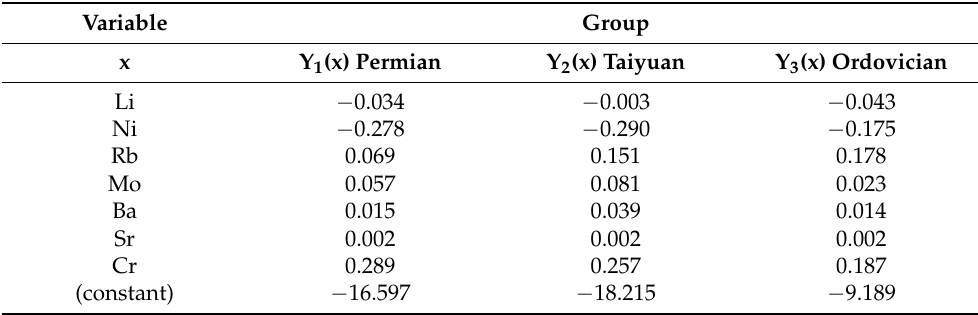
Table 8. Estimation of coefficients (C 0g , C 1g , C 2g , . . . , C pg ) of Bayes multi-class LDA function for trace elements.